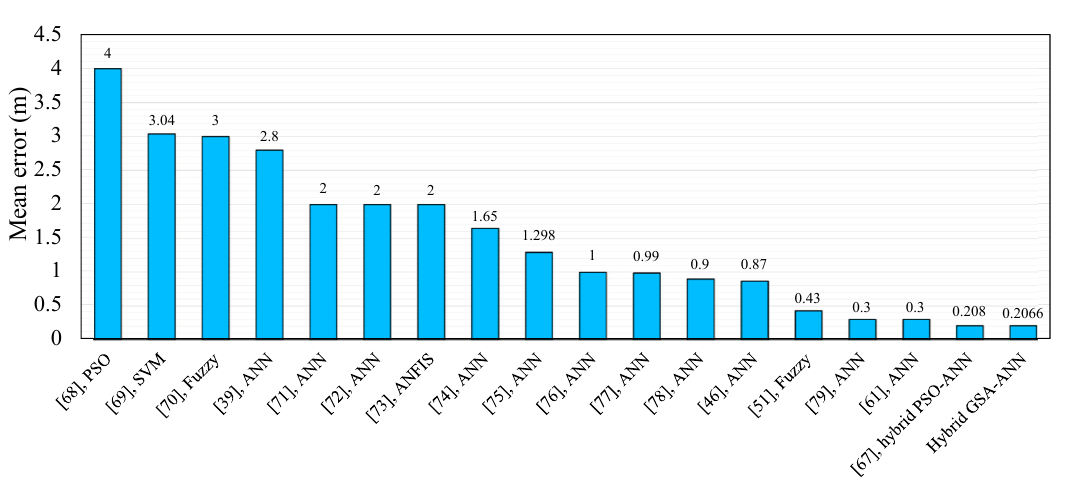
Figure 20. Comparison of GSA-ANN techniques with previous works for indoor environments.